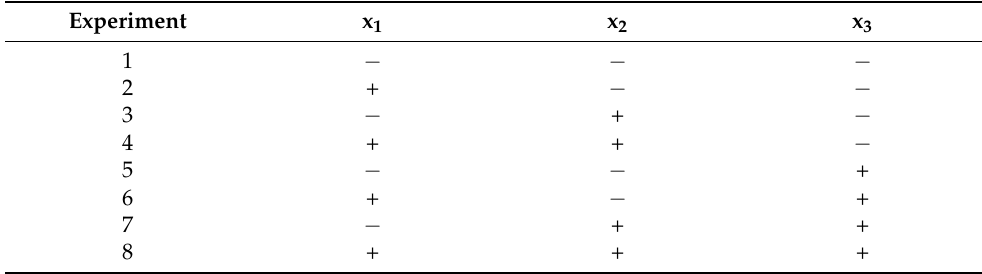
Table 4. Experimental plan of a 2 3 full-factorial combinatorial design; x 1 , x 2 , x 3 indicate variables x j of interest; +, − are the coded variables p ij at high level (+1) or at low level ( − 1); Z j objective